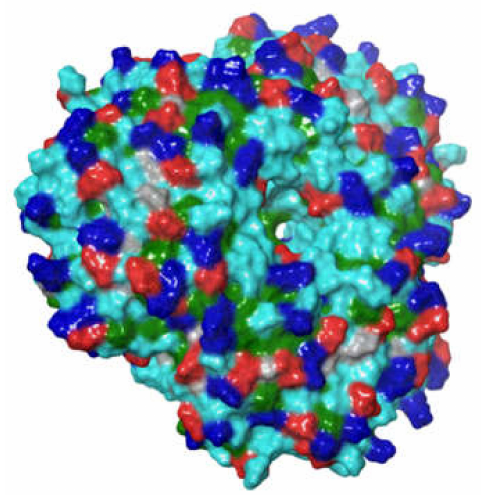
Figure 10. Proteins have highly heterogenous surfaces with cationic, anionic, polar, and non-polar regions exposed to the surrounding environment. The image here is of a soy protein prepared using the Maestro program (Schrodinger) from the crystal structure of soybean proglycinin A1AB1B homotrimer (Protein database 1FXZ). Key: Dark blue is positively charged regions, red is negatively charged regions, and green are hydrophobic